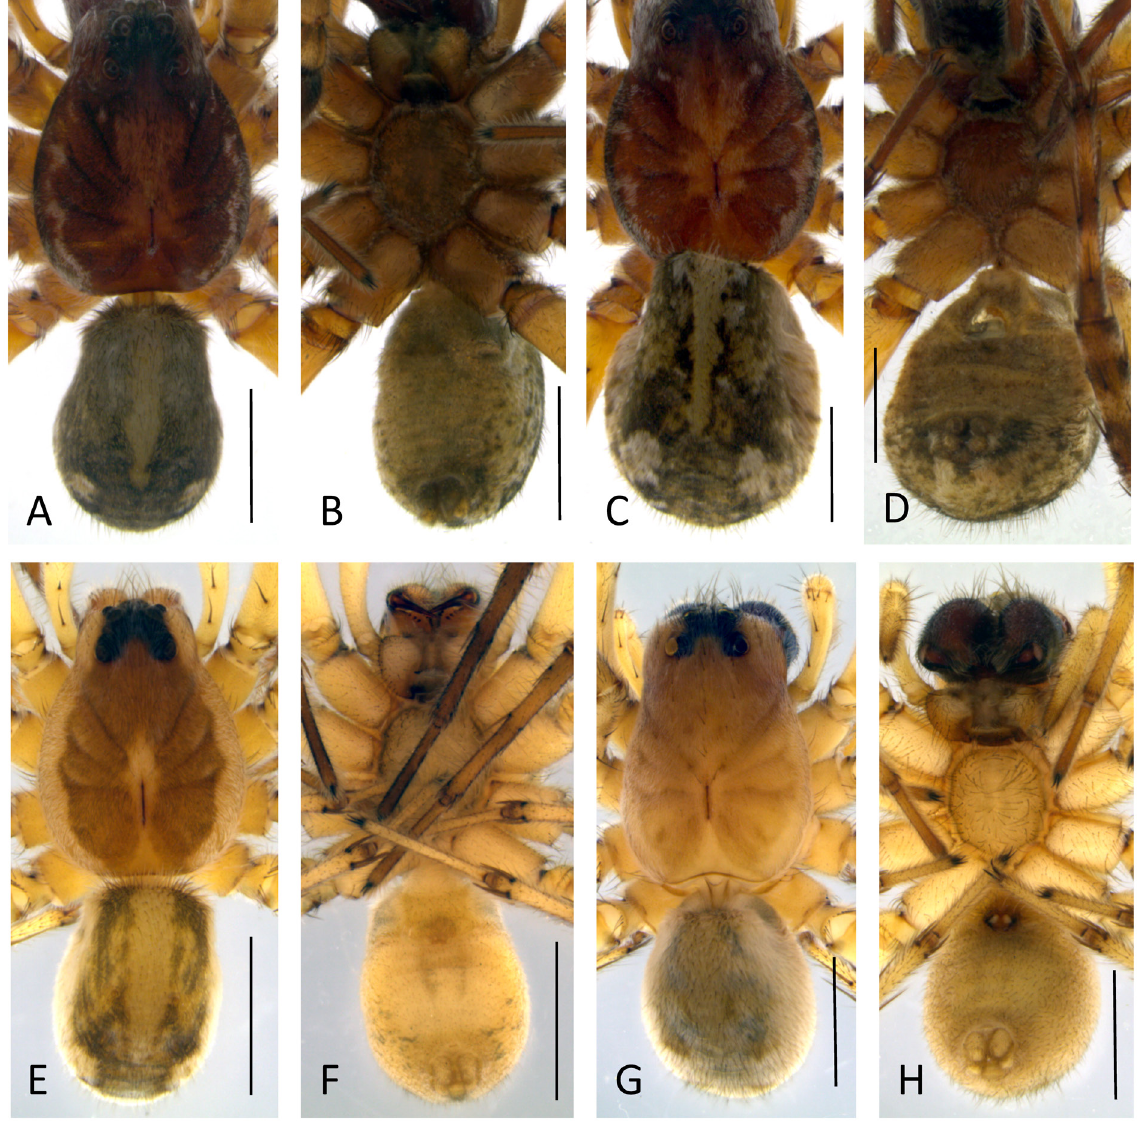
Fig. 10. Tetralycosa Roewer, 1960, microscopic photographs showing dorsal and ventral views. A–B . T. orariola sp. nov., ♂, holotype (WAM T62787). C–D . T. orariola sp. nov., ♀, paratype (WAM (WAM T70296). Scale bars: A–H =